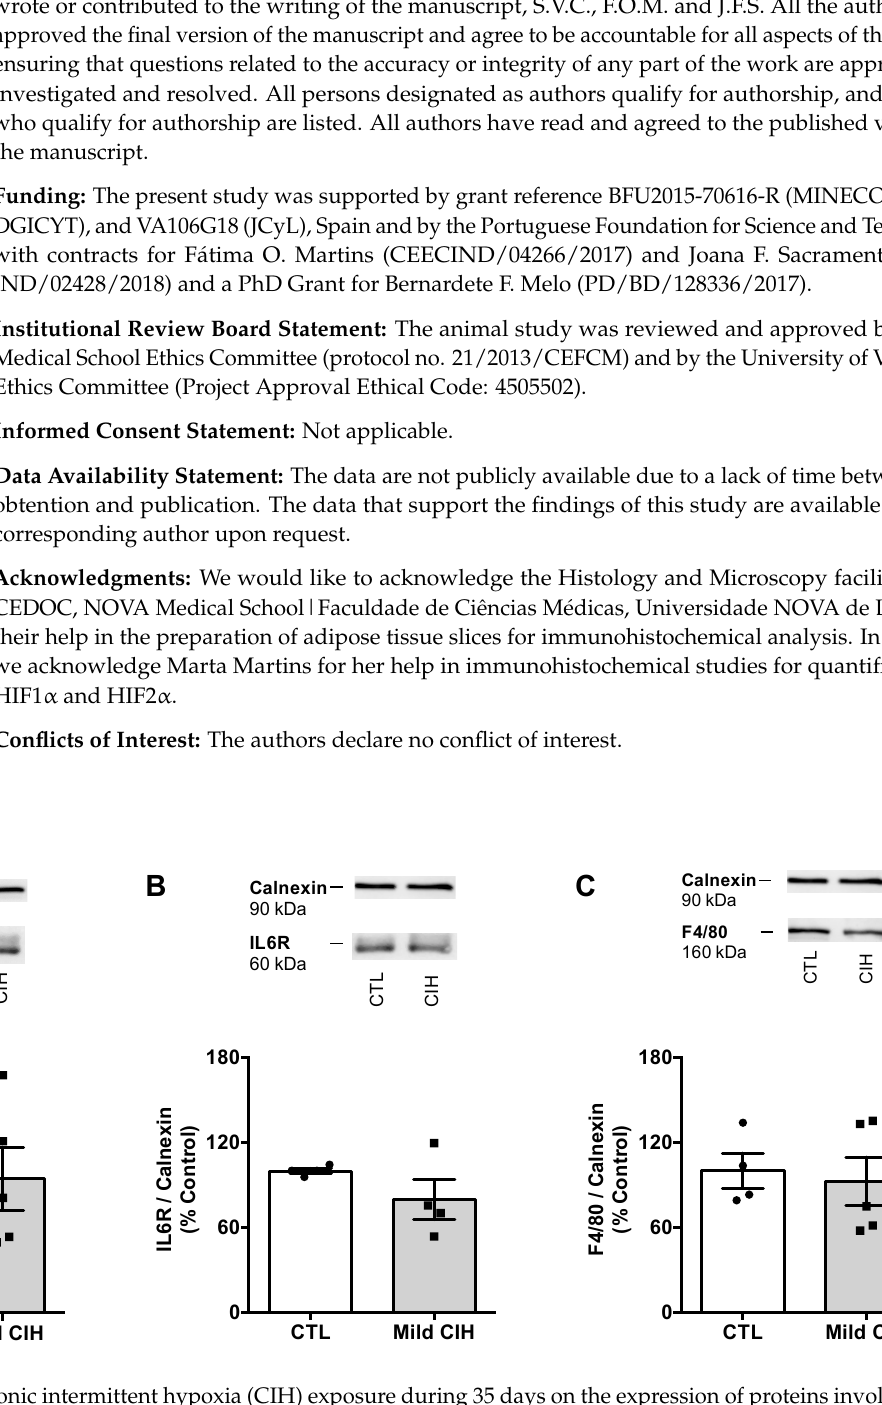
Figure A1. Effect of mild chronic intermittent hypoxia (CIH) exposure during 35 days on the expression of proteins involved in inflammation in the adipose tissue. Average relative interleukin 1 receptor (IL1R) (60 kDa) ( A ), interleukin 6 receptor (IL6R) (60 kDa) ( B ), and F4/80 (160 kDa) ( C ), a macrophage marker, immunoreactivity in the adipose tissue of controls and animals exposed to mild CIH expressed in relation to calnexin (90 kDa) ( n = 4–5). Representative Western blots for each protein studied, compared to the expression in control conditions and after mild CIH exposure, are depicted on top of the respective bar graph. Data are presented as means ±